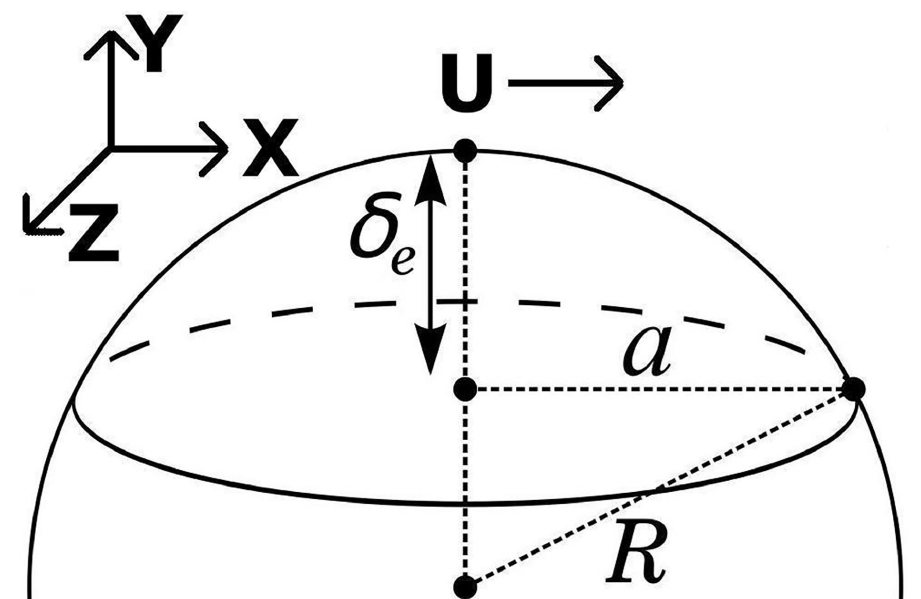
Fig 1. Definitions for indentation function defined by Eq 4, and the definition of the x , y , and z dimensions.